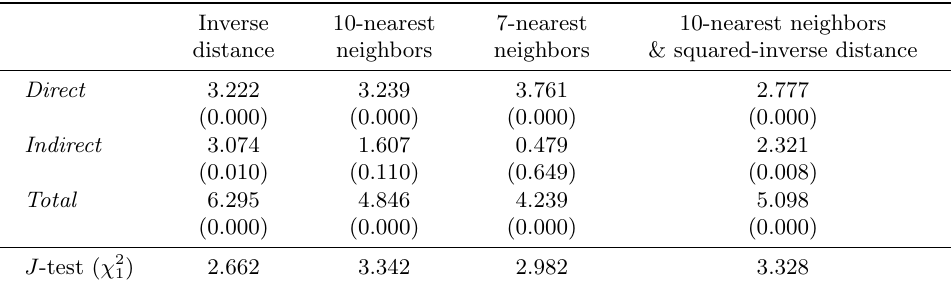
Table 4: Sensitivity of partial effects to different spatial weight matrices Inverse 10-nearest 7-nearest 10-nearest neighbors distance neighbors neighbors